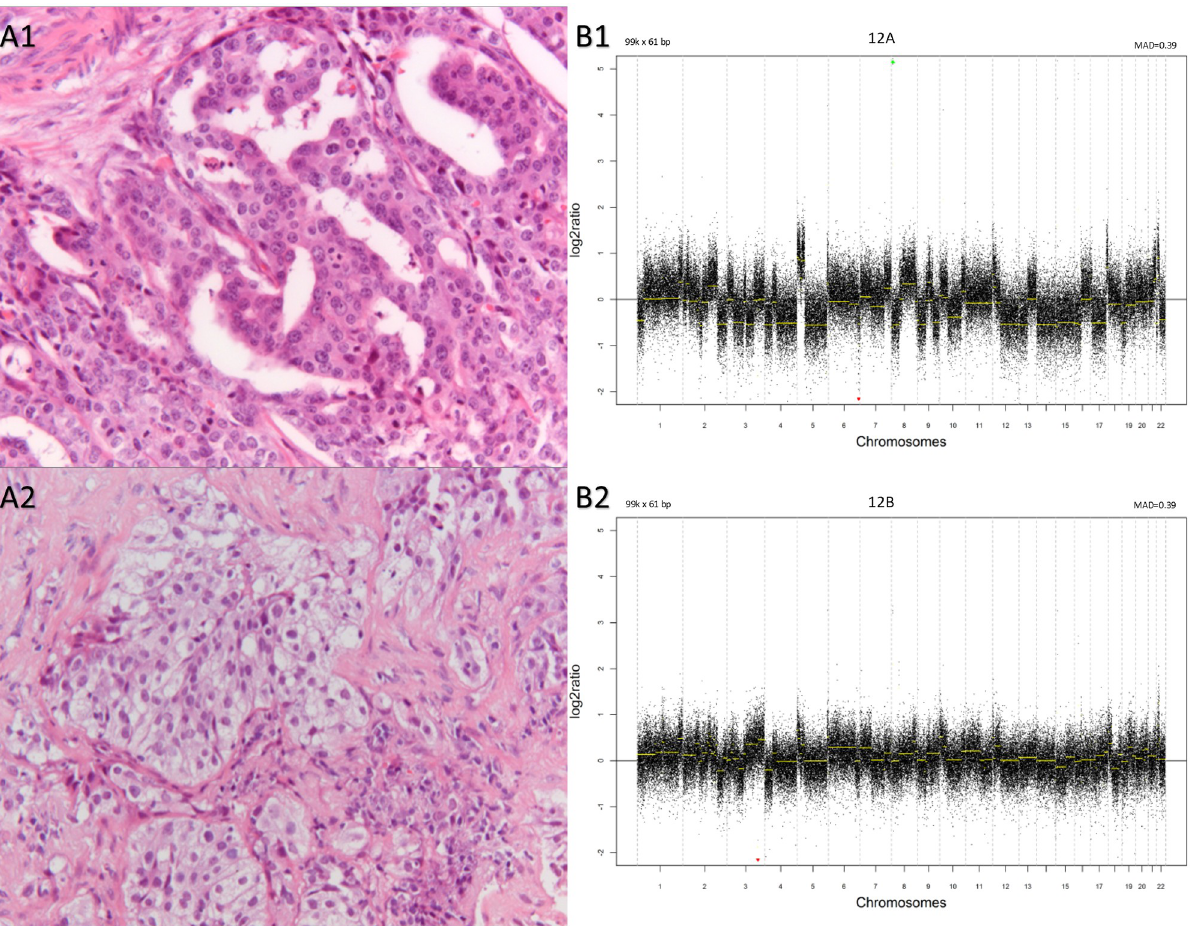
Fig 2. Example of a non-matching histologic pair with a clonal CNA-result. A1: adenocarcinoma from a breast resection. A2: non-small cell carcinoma, favoring squamous cell carcinoma (IHC: p63 positive; TTF-1/PAS-D/Alcian blue negative) from a lung biopsy (20x objective). B1 & B2: the corresponding CNA profiles. On the y axis is the log2 tumor to normal ratio and on the x axis the chromosomal position. Gain and loss are positive and negative log2 ratio, respectively. MAD = median absolute deviation. All array data are available in the Gene Expression Omnibus database, under accession number GSE87058. Mutation analysis: not performed on both samples. Martini-Melamed and ACCP-2013: not applicable. Follow-up: no sign of metastasis after 79 months.